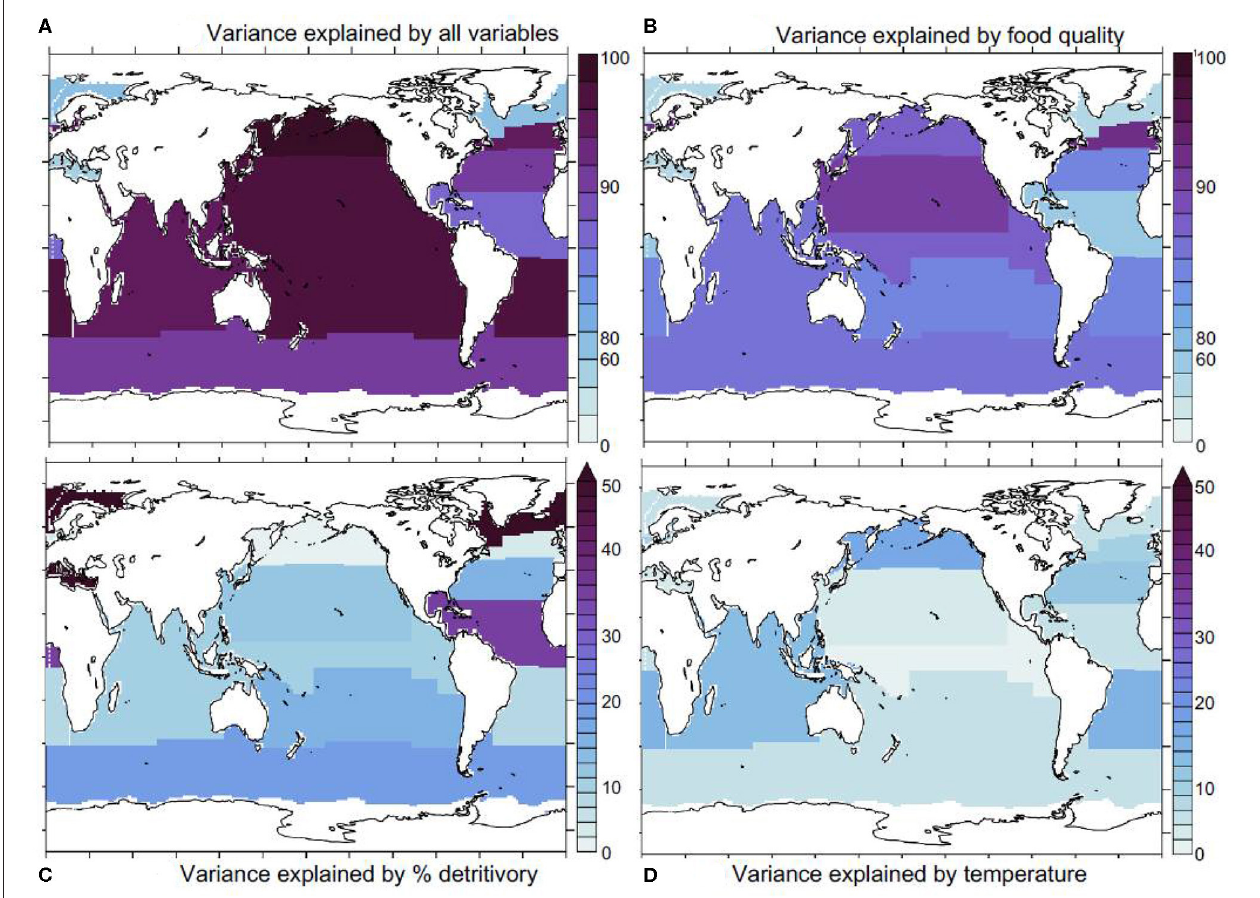
FIGURE 5 | Statistical model results. (A) proportion of iron assimilation efficiency variance explained by all factors (food quality, quantity, and % detritivory), (B) proportion of the explained variance due to food quality, (C) the proportion explained by % detritivory, (D) sea water temperature. Ice covered regions (defined as grid points with an annually averaged ice cover > 50%) are masked